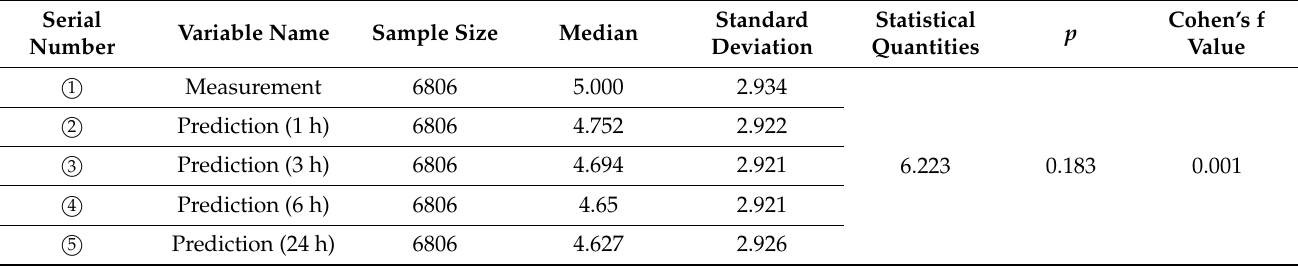
Table 5. The Friedman test results using CEEMDAN-LSTM.